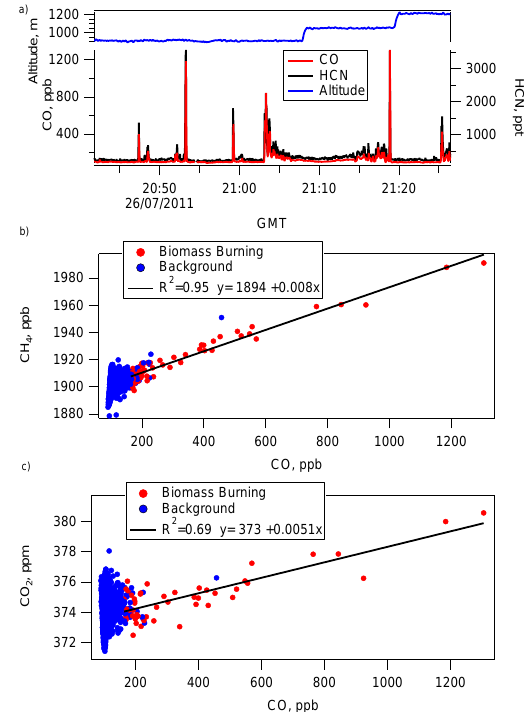
Fig. 5. (a) Time series of CO and HCN in fresh boreal biomass burning plumes measured by BORTAS flight B626 over northwest- ern Ontario. BB plumes were identified using simultaneous mea- surements of tracer species CO and HCN (the thresholds used were the periods during which CO and HCN were both 6 standard devi- ations greater than their local background). Strong linear relation- ships were found for both (b) CH 4 and (c) CO 2 with CO for mea- surements made within these plumes.